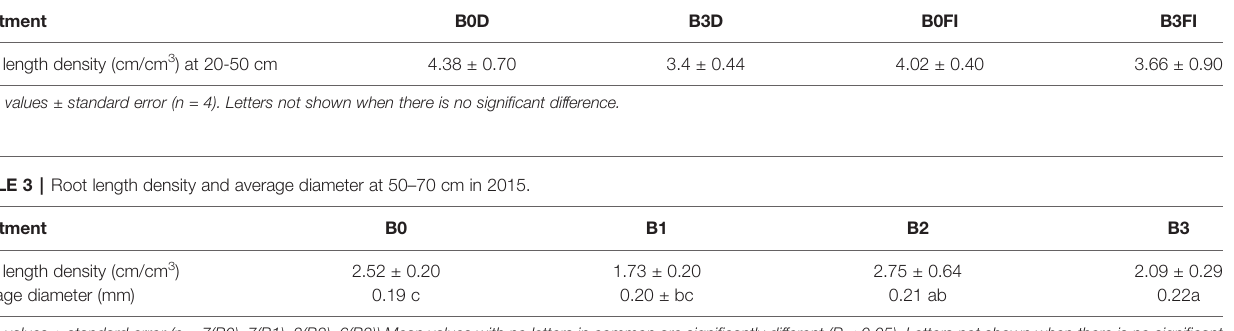
TABLE 4 | Root length density and average diameter at 50 – 70 cm for different biochar treatments in 2016. Treatment